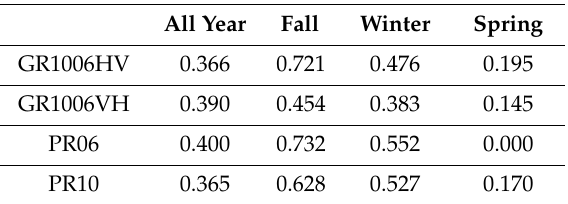
Table 2. Summary of the linear correlation coe ffi cients R from Figure 7; note that the values for spring are included; these are not shown in Figure